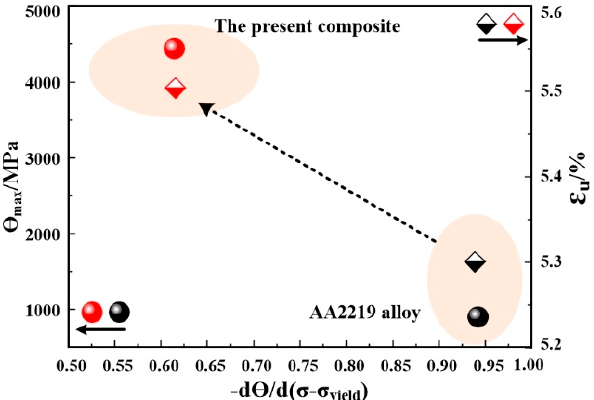
Figure 10. Correlation between uniform elongation, initial work-hardening (W-H) rate and dynamic recovery rate.